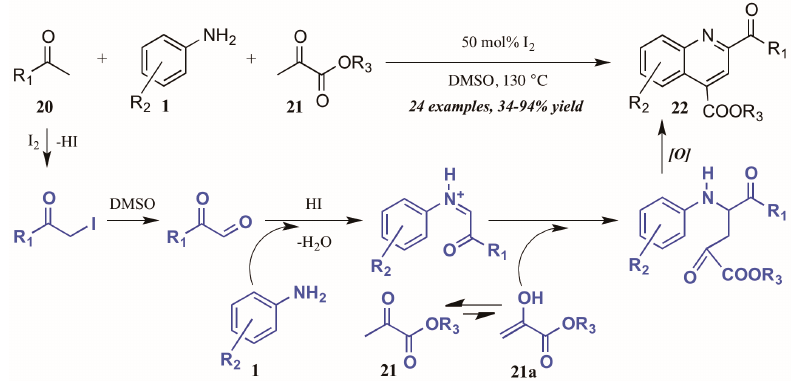
Figure 12. Iodine-catalyzed Povarov reaction.